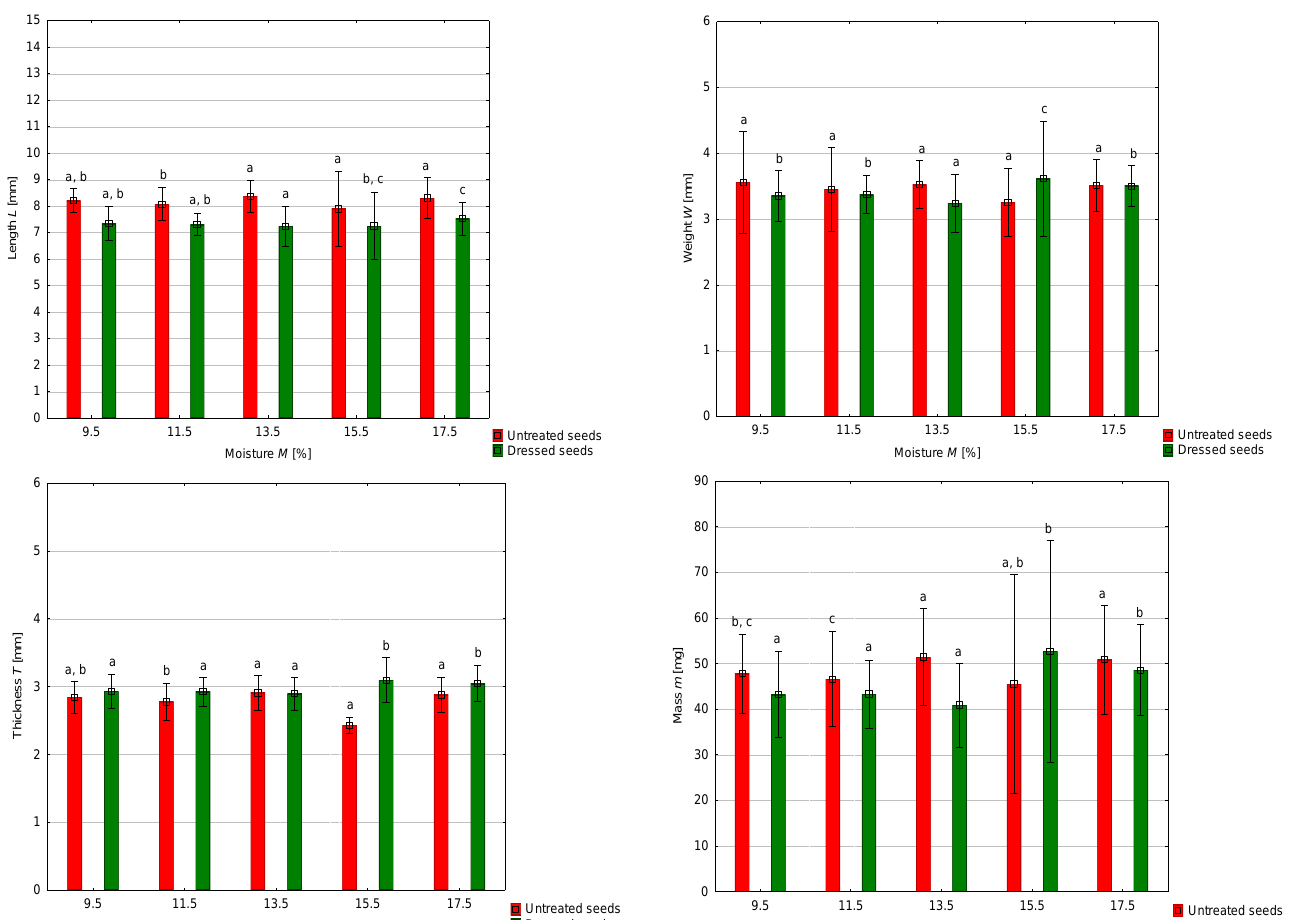
Figure 3. The physical parameters (the mean value and standard deviation) of winter triticale seeds. Note: a, b, c—different letters indicate significant differences at p < 0.05 in the group of dressed and untreated seeds (Duncan’s test).